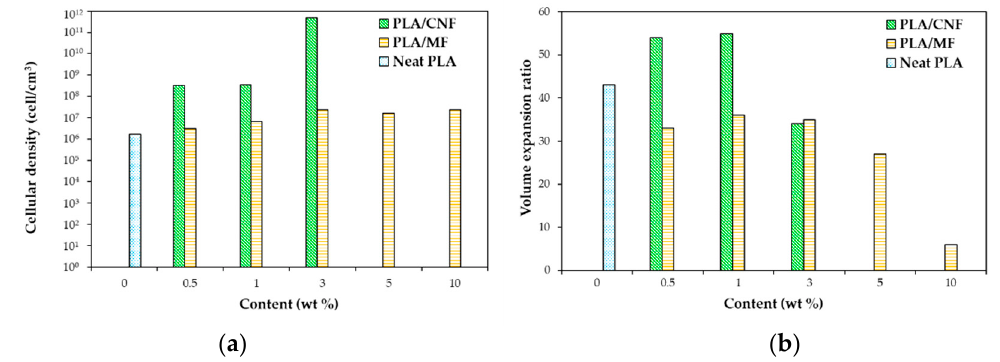
Figure 6. ( a ) Cellular density and ( b ) volume expansion ratio for PLA/cellulose foam composites. Data taken from Ding [120].